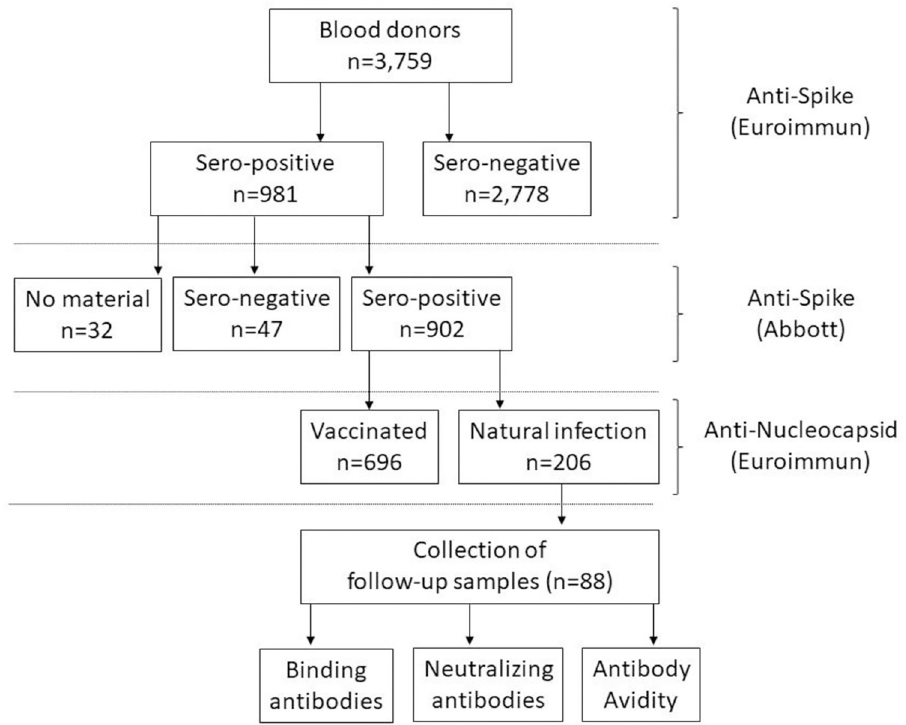
Fig 1. Flowchart illustrating the methodology design of the present study. A total of 3,759 blood donors were tested for anti-SARS-CoV-2 IgG antibodies over a one-year period. Samples were initially tested using a semiquantitative assay. Seropositive results were verified using a quantitative serological test. We additionally performed an assay to detect antibodies against the nucleocapsid, only being expressed by convalescents, to differentiate between vaccinated and convalescent blood donors among the positive samples. Using this approach, we identified 206 naturally infected and 696 vaccinated blood donors within our cohort. We collected and analyzed follow-up samples from 88 naturally infected individuals to assess the strength and persistence of anti-SARS-CoV-2 IgG binding- and neutralizing antibodies as well as the antibody